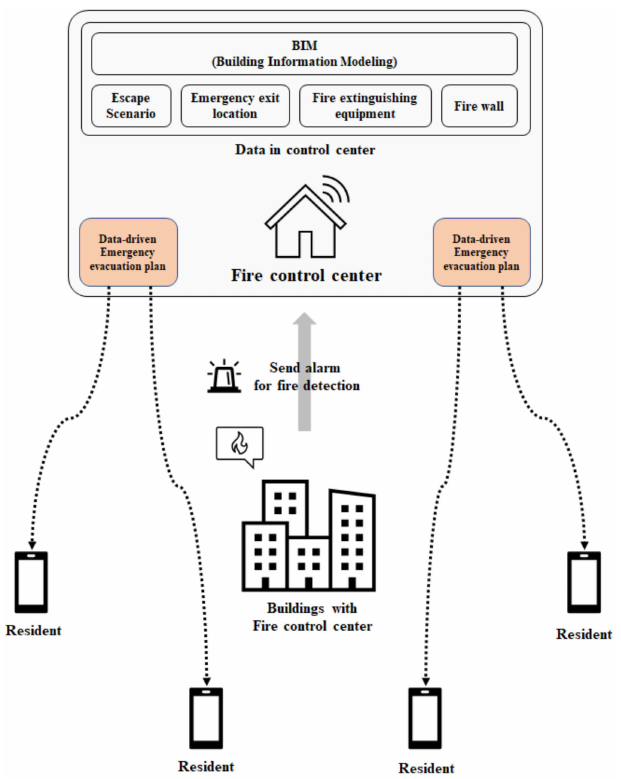
Figure 12. Sample operation of fire control